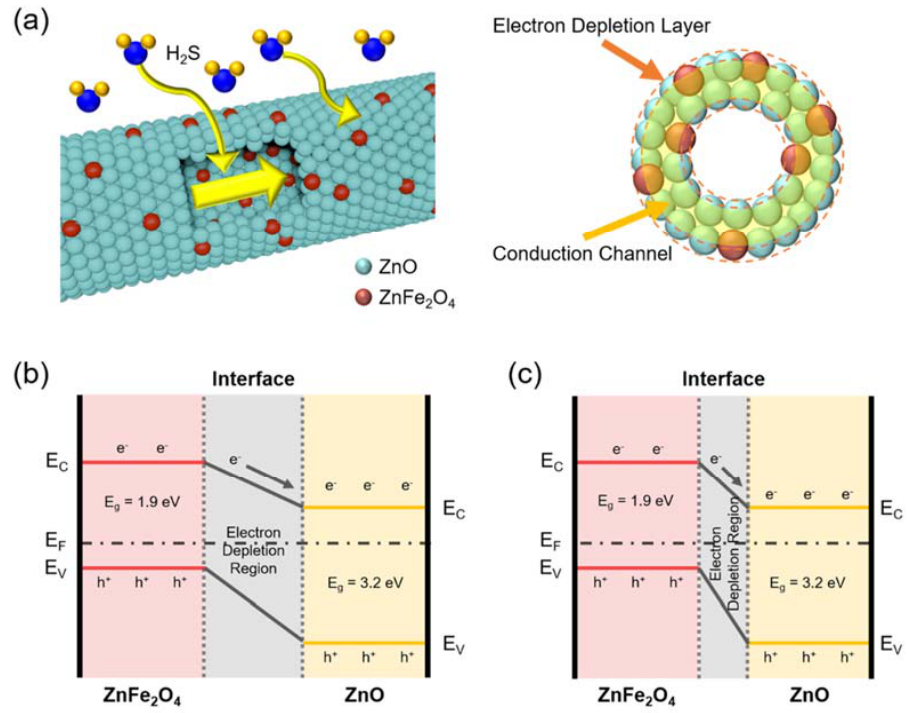
Figure 4. ( a ) Schematic of mechanism of the ZnO ‐ ZnFe 2 O 4 hollow nanofiber ‐ based gas sensor.